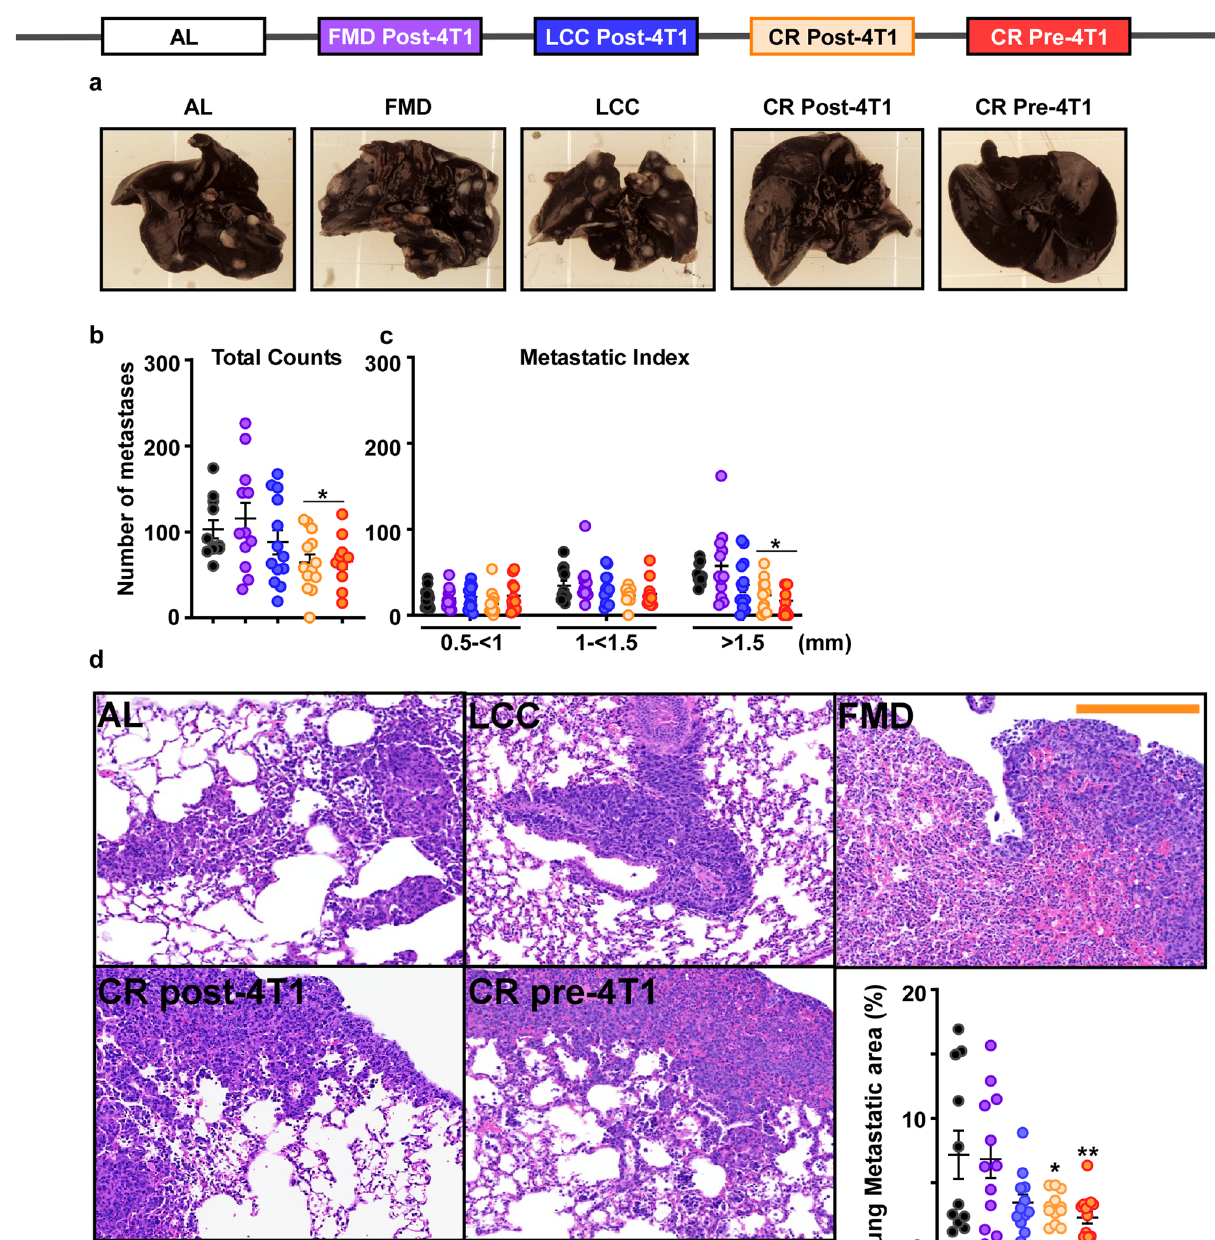
Fig. 3 Preventive and therapeutic effect of CR but not caloric cycling in reducing metastatic burden. a Representative images demonstrating the appearance of white masses in india ink-stained lungs, indicative of metastases. b Macroscopic quanti fi cation of lung metastases. c Macroscopically, lung metastases were scored in a blinded fashion and divided into three groups based on size: 0.5 < 1 mm, 1 < 1.15 mm, and >1.5 mm. Large primary tumors have a greater metastatic index. d Representative images and histological quanti fi cation of lung metastatic areas [H&E staining, original magni fi cation ×200]. Scale bar = 200 μ m. The lung and primary tumors presented in Fig. 2 and Supplementary Fig. 3 for each dietary intervention are from the same mouse. Most of the data are represented as scatter plots with mean values ± SEM. One-way ANOVA with Tukey post hoc analysis was used to determine statistical signi fi cance with * p < 0.05 compared to AL. b , c AL, n = 11; FMD post-4T1, n = 12; LCC post-4T1, n = 13; CR post-4T1, n = 13; CR pre-4T1, n = 11. d AL, n = 11; FMD post-4T1, n = 12; LCC post-4T1, n = 12; CR post-4T1, n = 12; CR pre-4T1, n = 13 mice per treatment group. Source data are provided as a Source Data fi